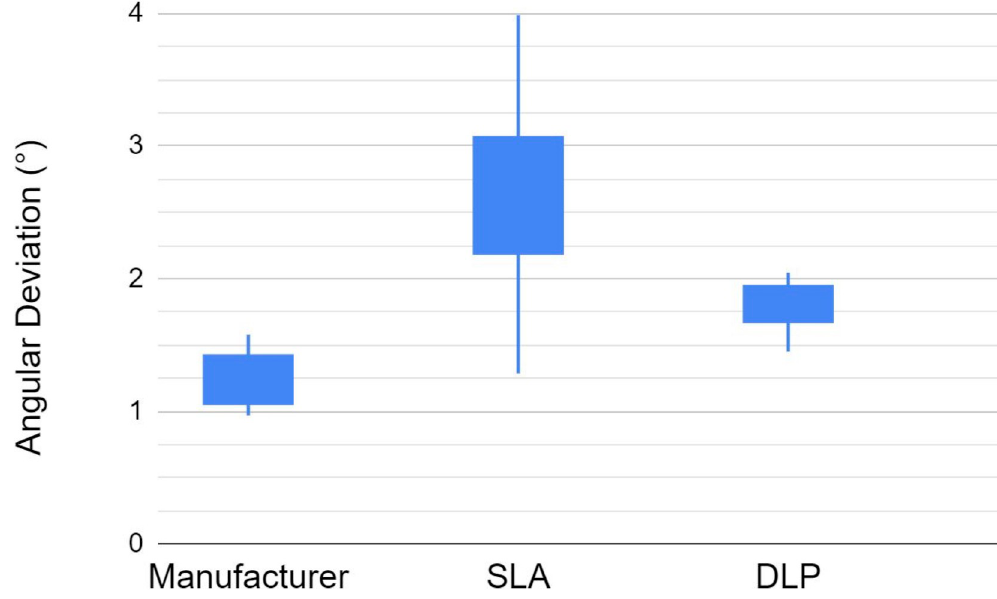
Fig 6. Angulation deviations (˚) of the manufacturer’s scan bodies (control), the SLA and DLP printed scan bodies.